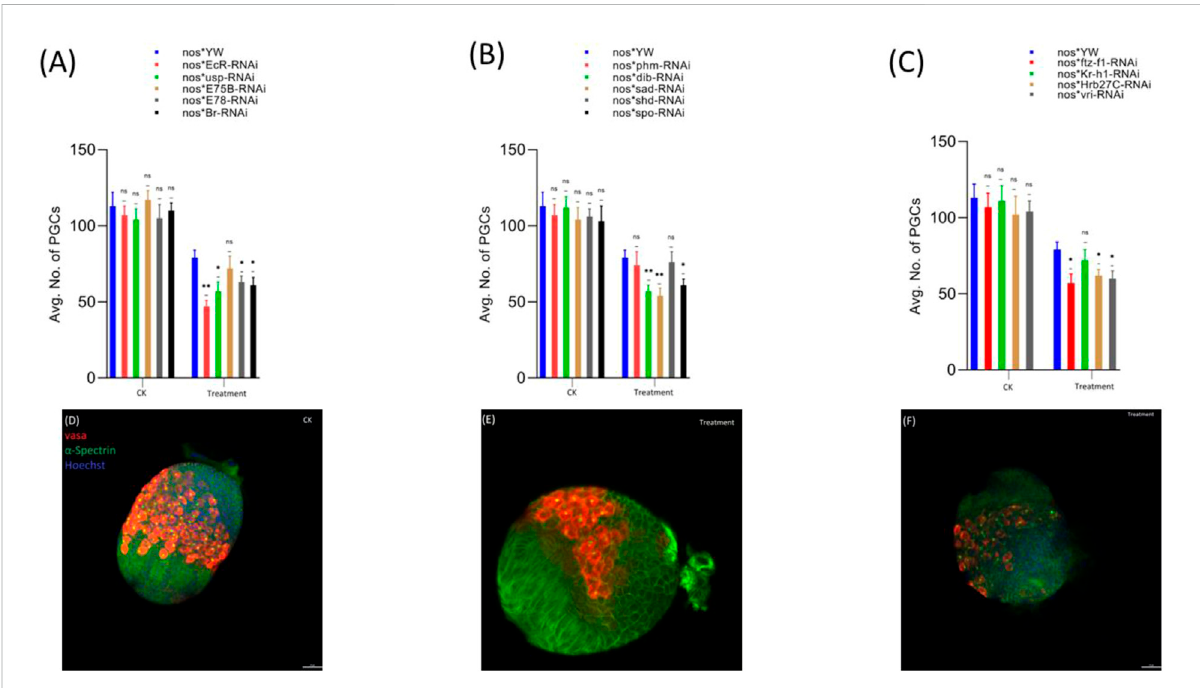
FIGURE 2 Effect of cyromazine on the germ cells of larval ovaries. (A) RNAi of ecdysone-responsive primary genes and the effect of cyromazine on the PGCs. (B) RNAiofHalloween genesandtheeffectofcyromazine onthePGCs. (C) RNAiofecdysone-responsivegenesandtheeffectofcyromazine on thePGCs.CK meansthat the fl ieswere fed on anormal diet, while treatment meansthe fl ies were fedinsecticide containing diet. (D) Larval ovary fromtheCKgroup. (E,F) Larvalovariesfromthecyromazine-treatedgroup(scalebar,25 μ m).Forthe t -test:* p < 0.05;** p < 0.01;*** p < 0.001; ns indicates not signi fi cant ( p >